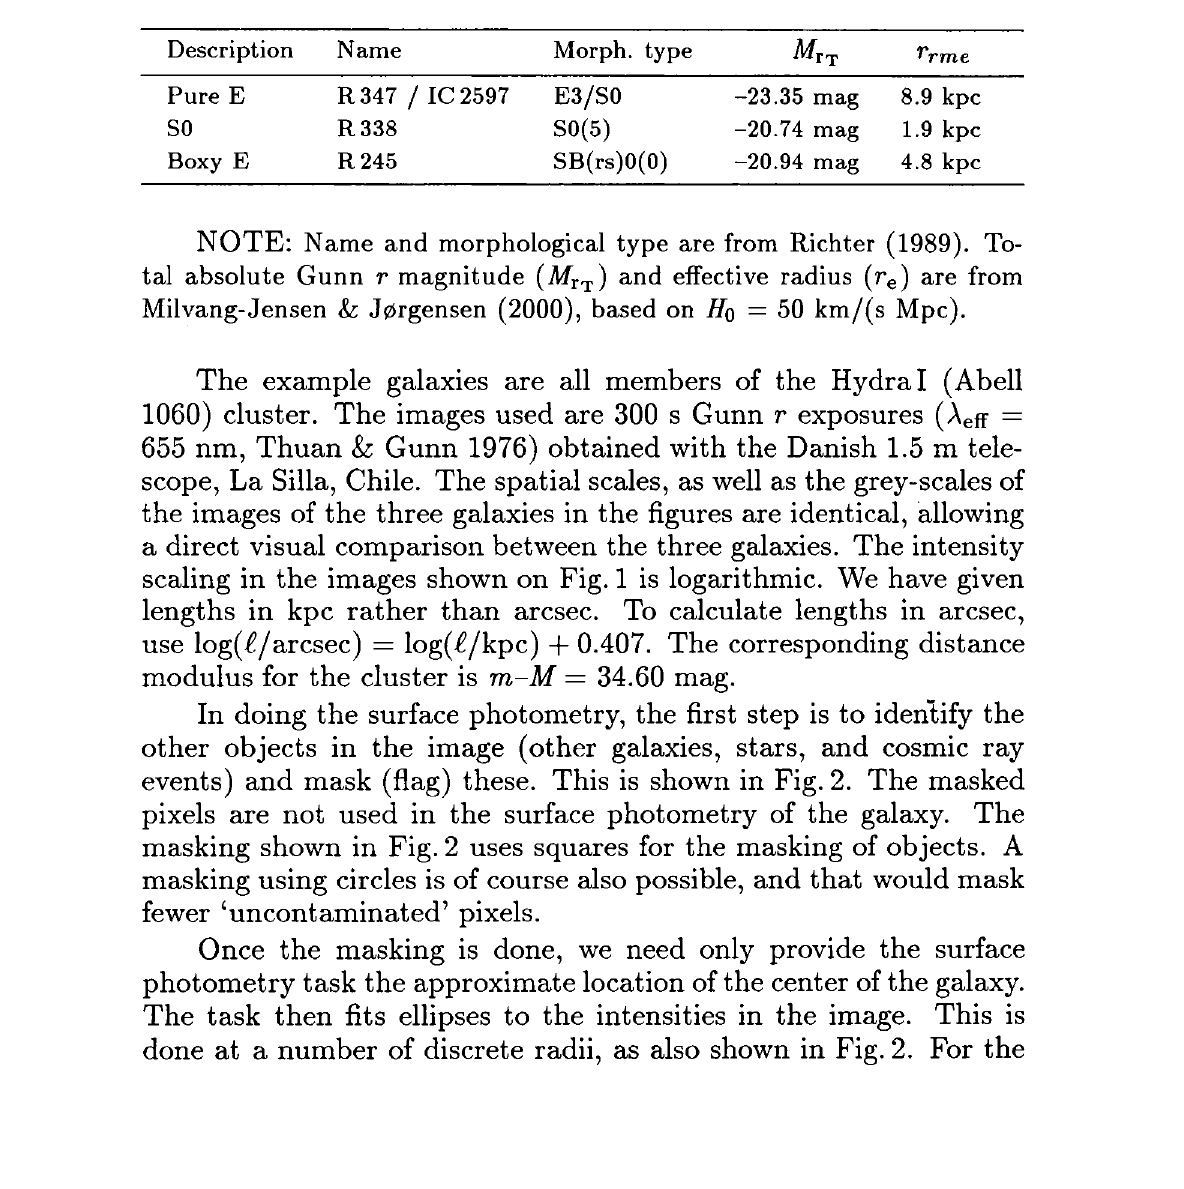
Table 1. The three example